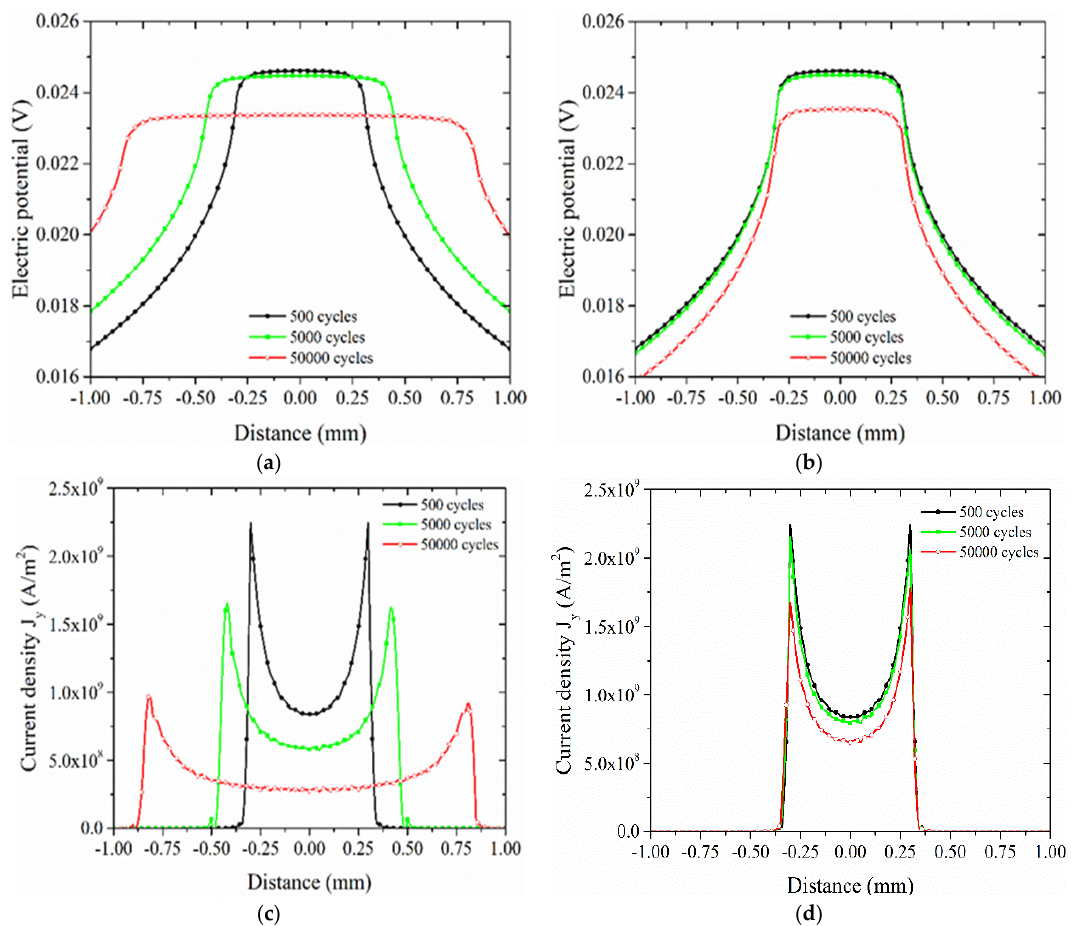
Figure 8. ( a ) Evolution of fretting wear profile on the copper specimen and ( b ) evolution of the maximum fretting wear depth.